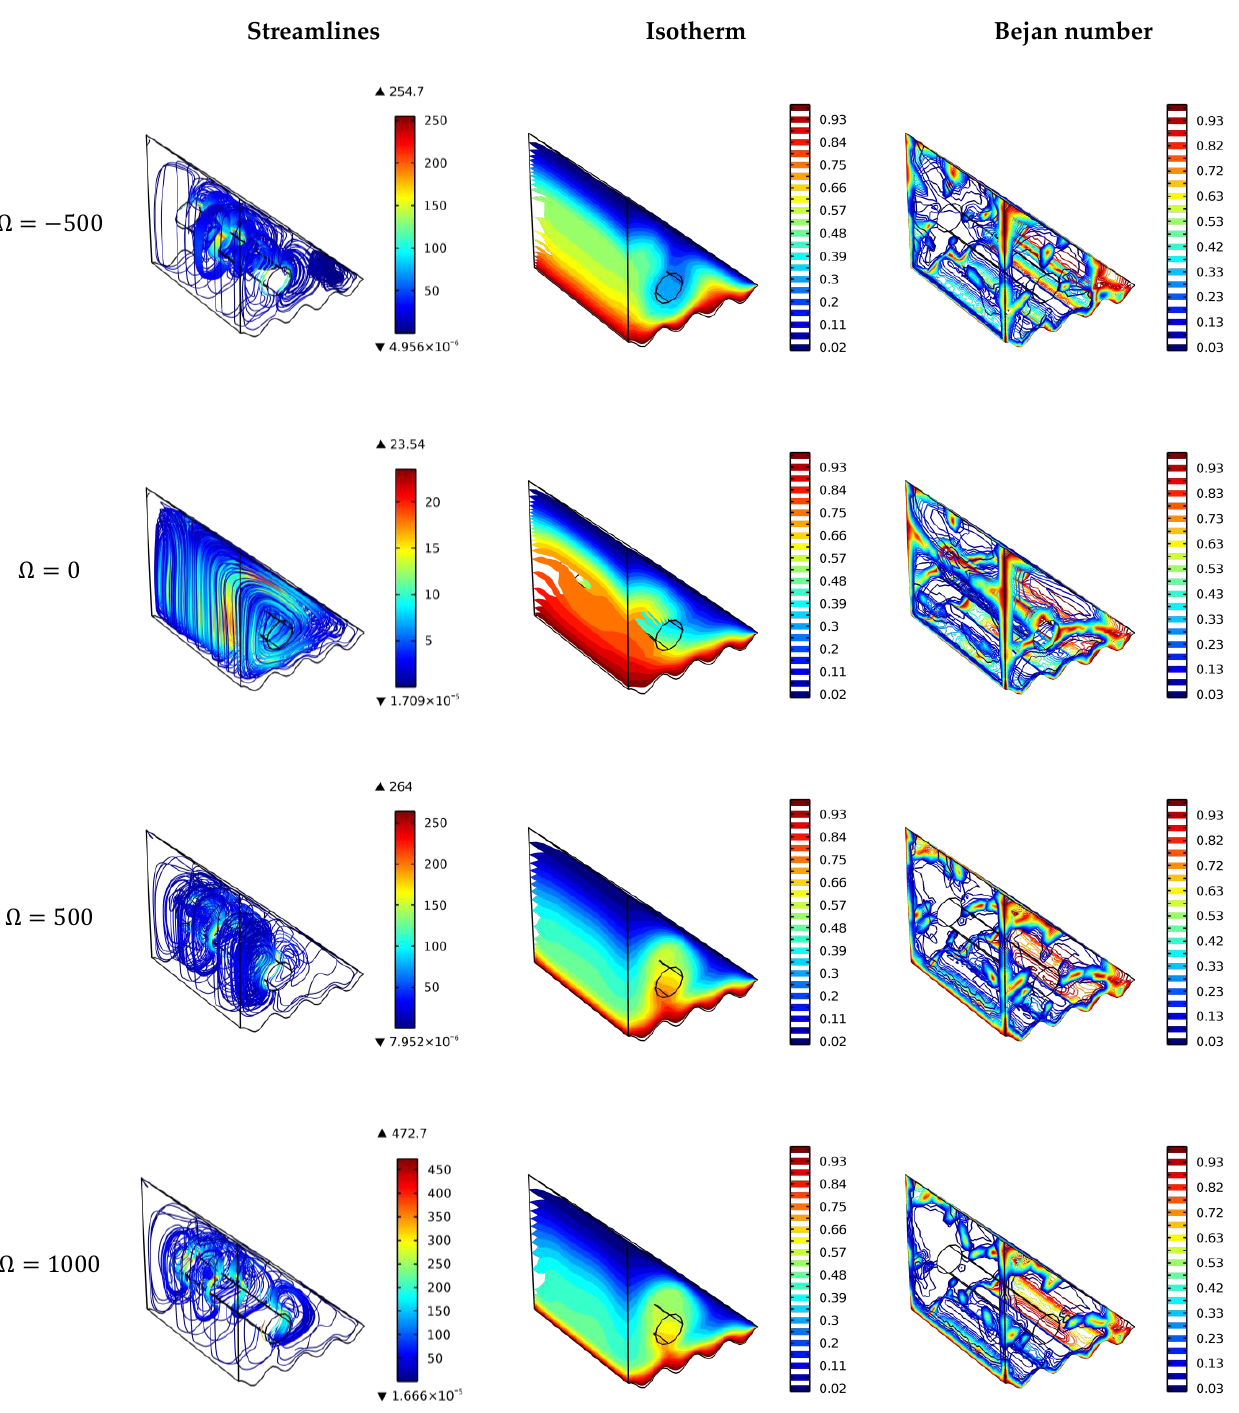
Figure 3. Surface plots of the velocity, temperature, and Bejan number for various cylinder speed values and directions.